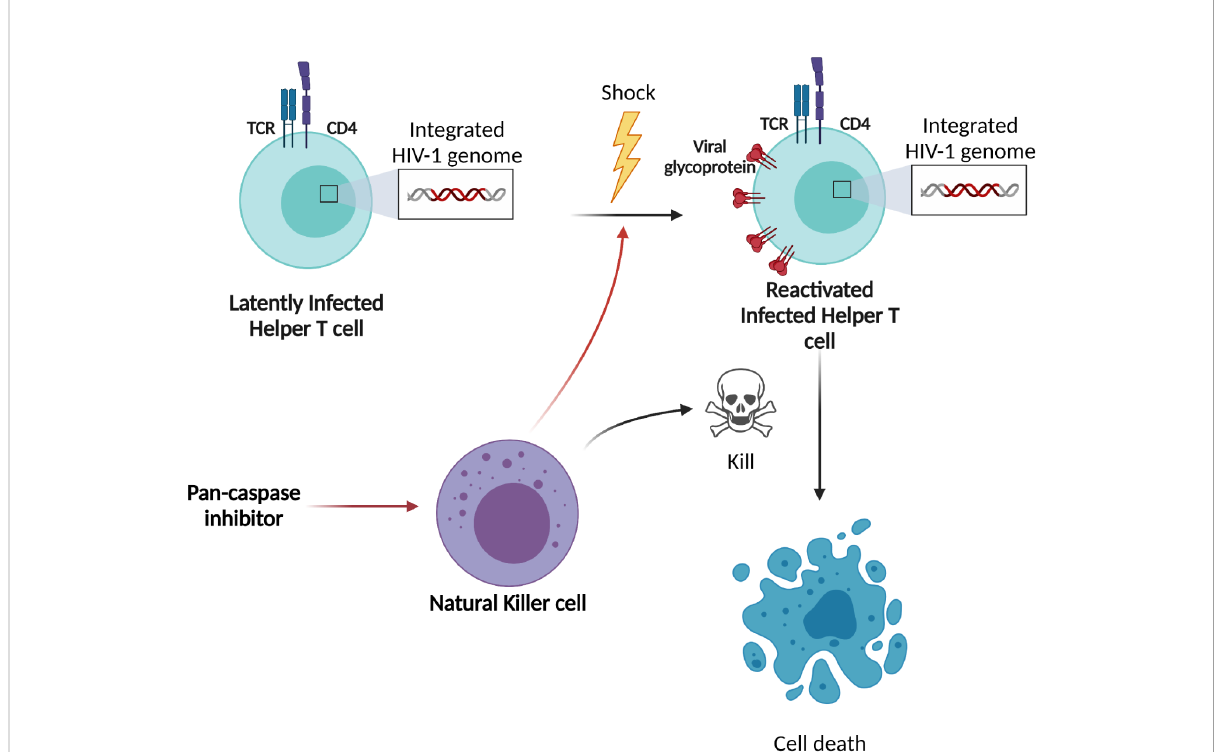
FIGURE 7 Schematic overview of shock-and-kill strategy and our fi ndings. The original shock-and-kill strategies use LRAs to directly stimulate the HIV-1 latently infected cells. After latency reversal, these HIV-1 reactivated cells are eliminated by cytotoxic lymphocytes, such as NK cells. Based on our data, our proposed shock-and-kill strategy aims to stimulate NK cells with pan-caspase inhibitors resulting in the release of an LRA from the NK cells to provide the “ shock ” towards HIV-1 latently infected cells, followed by the “ kill ” of the reactivated cells by the same NK